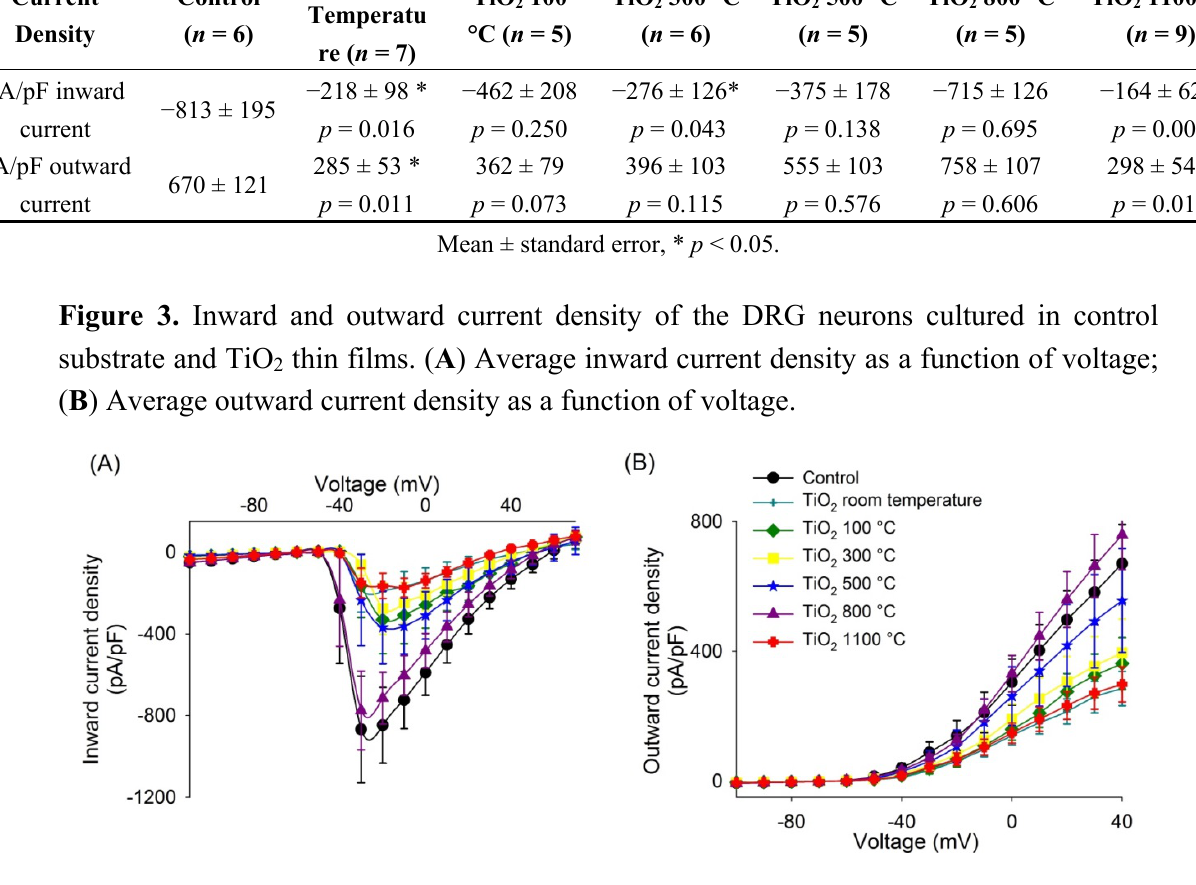
Figure 4. Representative action potential recordings of the DRG neurons on control thin films annealed at 1100 °C. ( A ) Action potential produced by a 100 pA substrate and TiO 2 depolarizing current pulse; ( B ) Phase-plane plot of the action potential shown in panel A. 1—AHP, 2—threshold, 3—maximum depolarization rate, 4—maximum repolarization rate; ( C ) Action potential caused by 100 pA depolarizing current pulse in a neuron cultured on the TiO film; ( D ) Phase-plane plot for the action potential shown in panel C. 1—AHP, 2 2—threshold, 3—maximum depolarization rate, 4—maximum repolarization